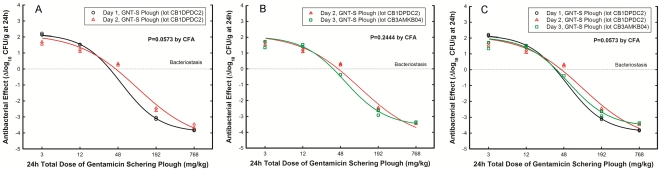
Repeatability of the animal model to determine therapeutic equivalence of generic gentamicin products.The graphs illustrate the non-significant differences on the innovator's pharmacodynamic profiles when a single (within-batch variation, Panel A), or a second (between-batch variation, Panel B), or multiple lots (total variation, Panel C) are used to treat E. coli SIG-1 in vivo. In all graphs showing data obtained with the animal model every data-point represents one mouse (mean of two thighs; if standard errors of the mean were to be included, the bars would not be longer than 0.5 logs).